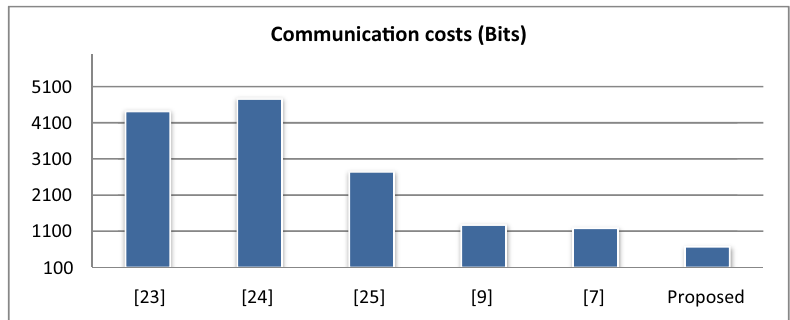
Figure 5: Comparison of communication